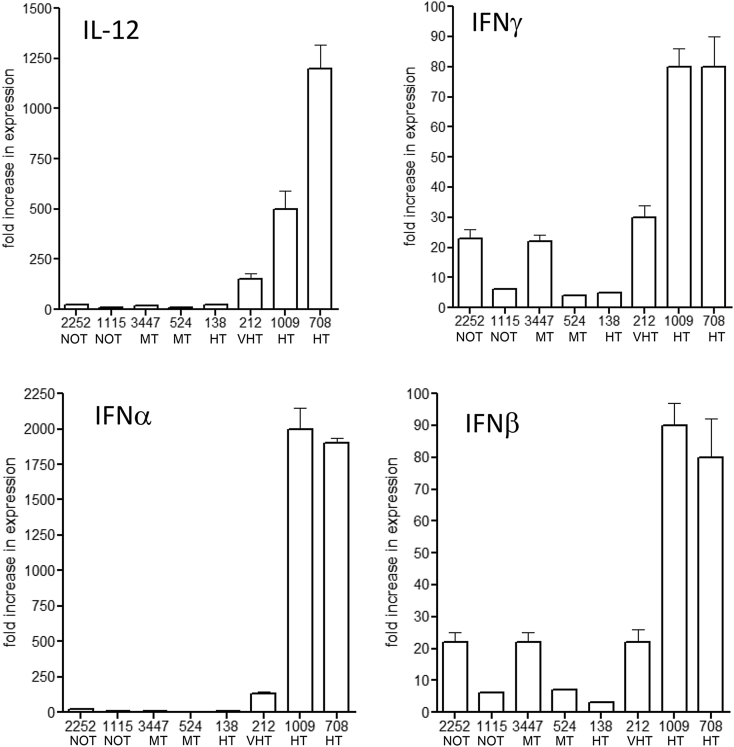
RT-PCR signals for key TH1-associated responses in the lungs of guinea pigs infected with a panel of clinical strains of M. tuberculosis. Data show as mean of three measurements ±SEM.